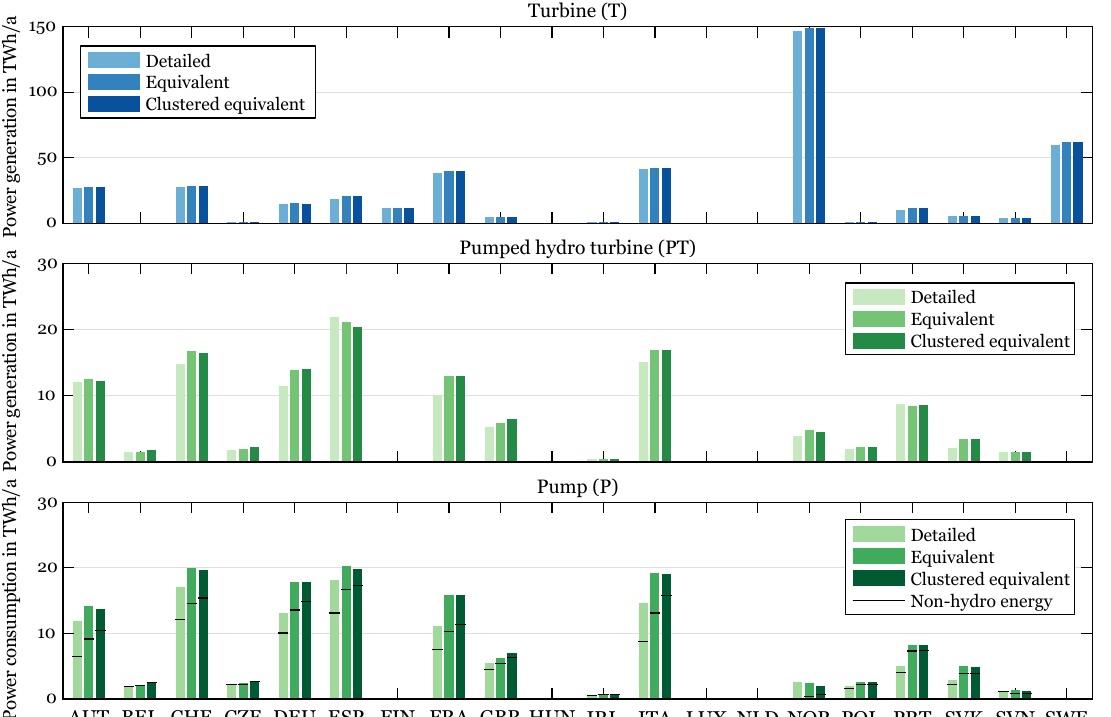
Figure 8. Annual sum of energy generation and consumption of detailed, equivalent, and clustered equivalent hydro system models in all considered market areas (black bars display share of non-hydro energy consumption of